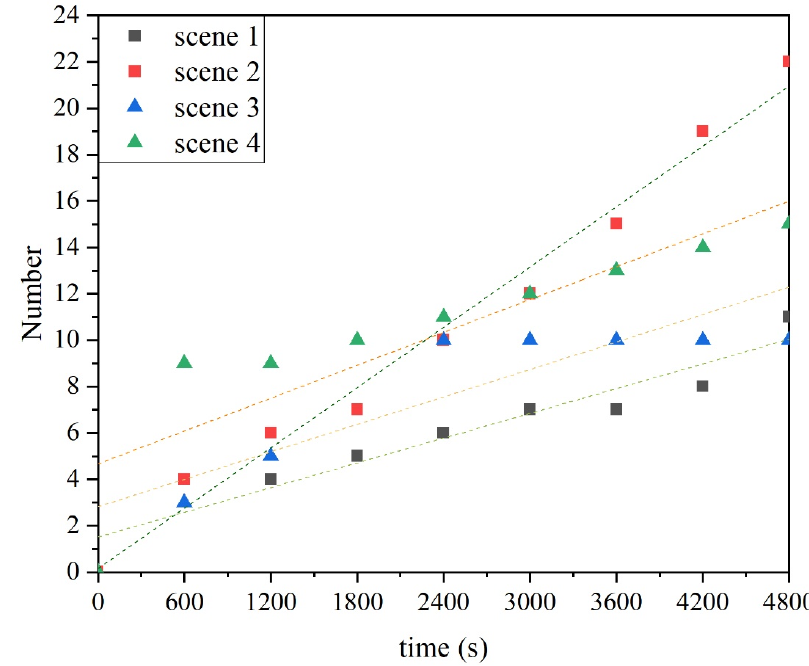
Figure 18. The number of dwellings on fire in different scenarios over